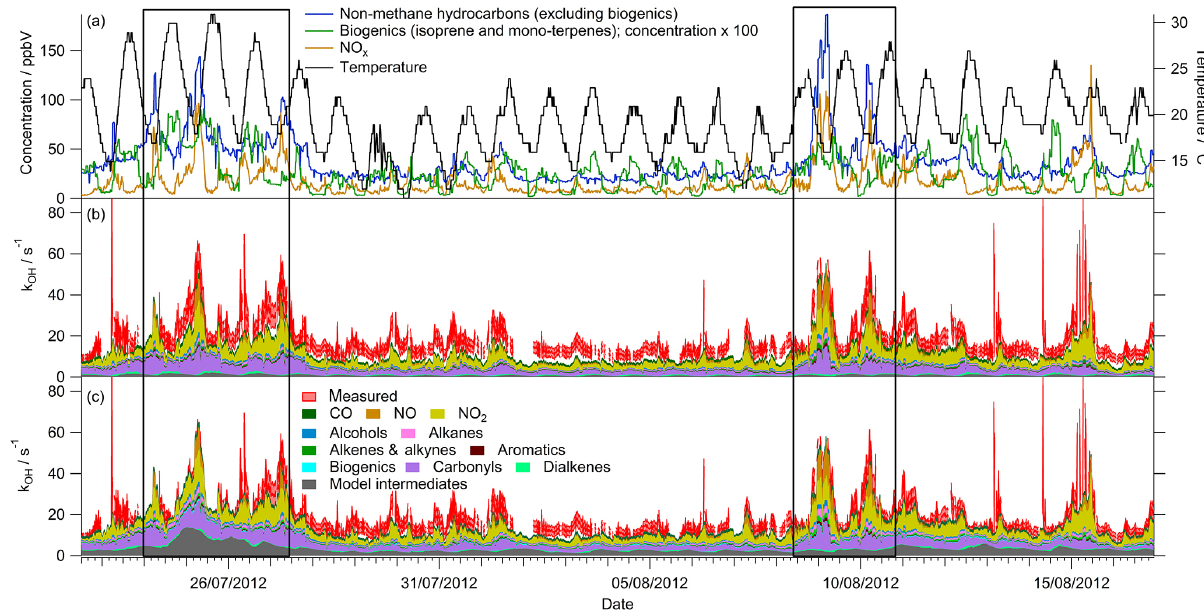
Figure 1. (a) Time series of non-methane hydrocarbons (excluding biogenics), biogenics (isoprene and monoterpenes), NO x and temperature, (b) measured OH reactivity time series and breakdown of modelled OH reactivity when only the standard set of VOCs are used as model constraints and (c) measured OH reactivity time series and breakdown of modelled OH reactivity when VOCs measured by the dual-channel GC-FID and GC GC-FID instruments are used as model constraints (see Table 1 for details). Periods of more polluted easterly flows are × highlighted. The averaging period is 15min. The 1 σ uncertainty of the OH reactivity measurements (red shading) was, on average,